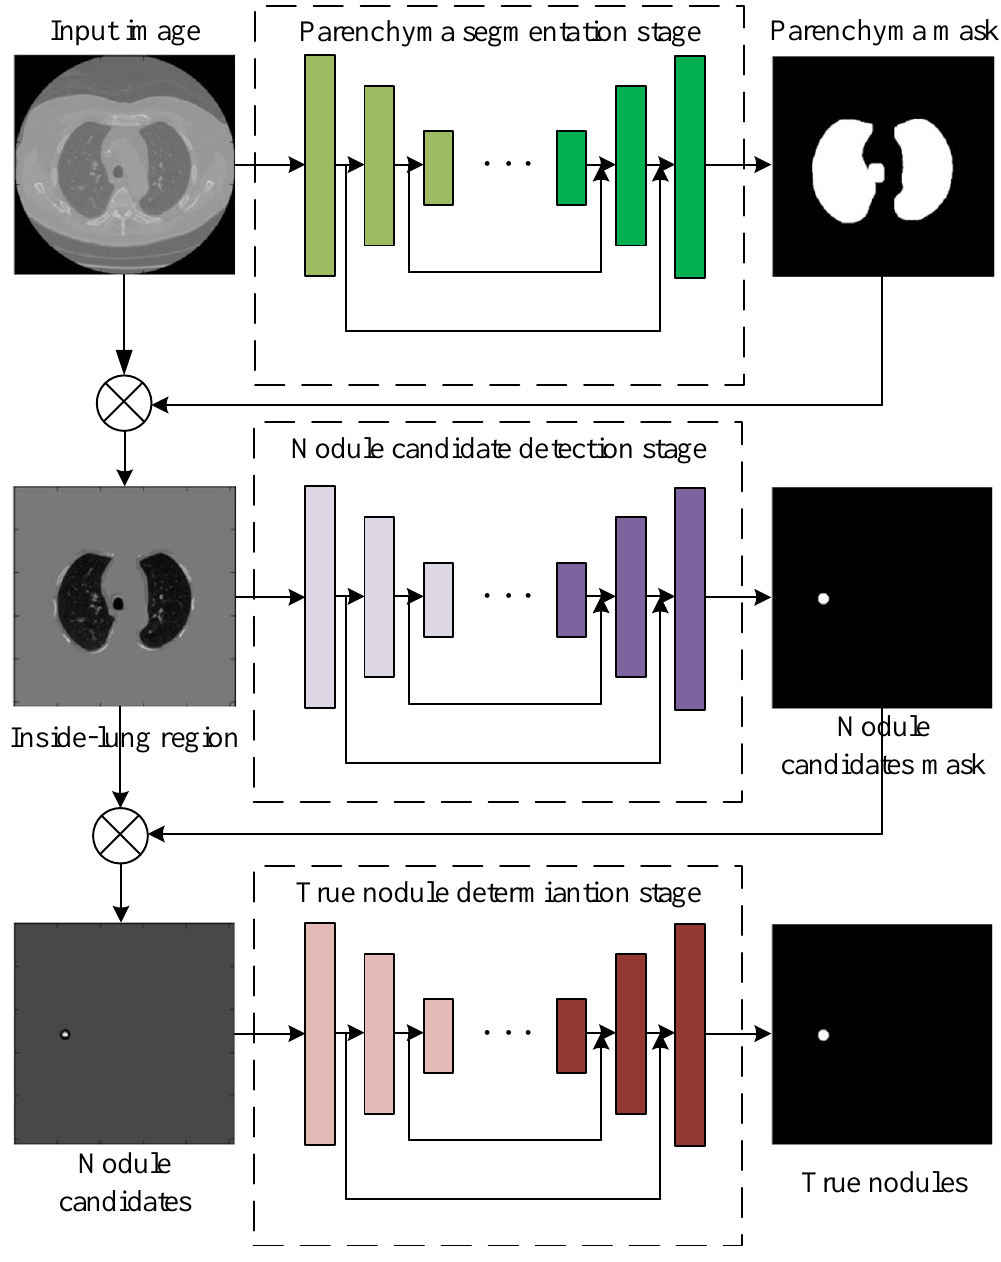
Figure 1. The framework of the proposed pulmonary nodule detection method by cascading three sub-networks for lung parenchyma segmentation, nodule candidate detection and true nodule